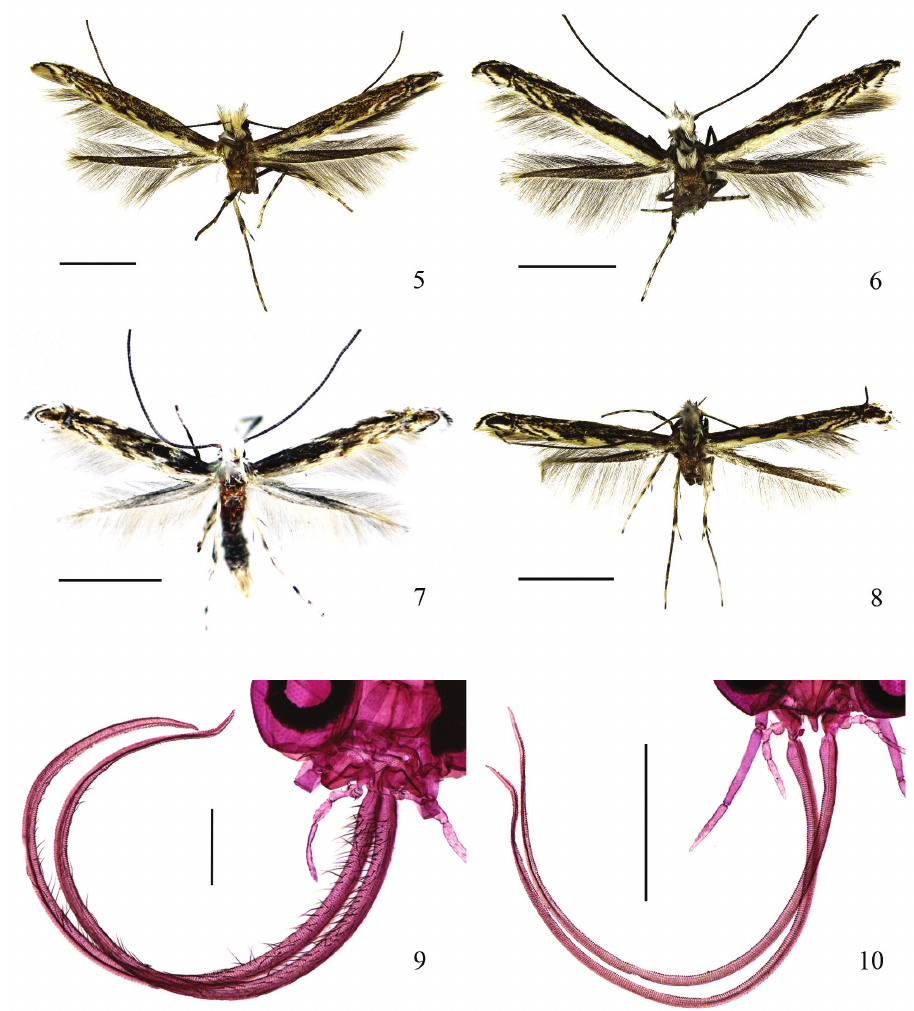
Figures 5–10. Adult morphology of Epicephala spp. 5–8 Adults: 5 E. domina sp. n., female paratype 6 E. impolliniferens sp. n., female paratype 7 E. camurella sp. n., male paratype 8 E. angustisaccula sp. n., male paratype 9–10 Morphology of female proboscis: 9 E. domina sp. n., female paratype, head slide No. WZB14297 (genitalia slide No. WZB14295 for determination) 10 E. impolliniferens sp. n., female para- type, head slide No. WZB14298 (genitalia slide No. WZB14160 for determination). Scale bar: 2.0 mm ( 5–6 ); 0.5 mm ( 9, 10 ).